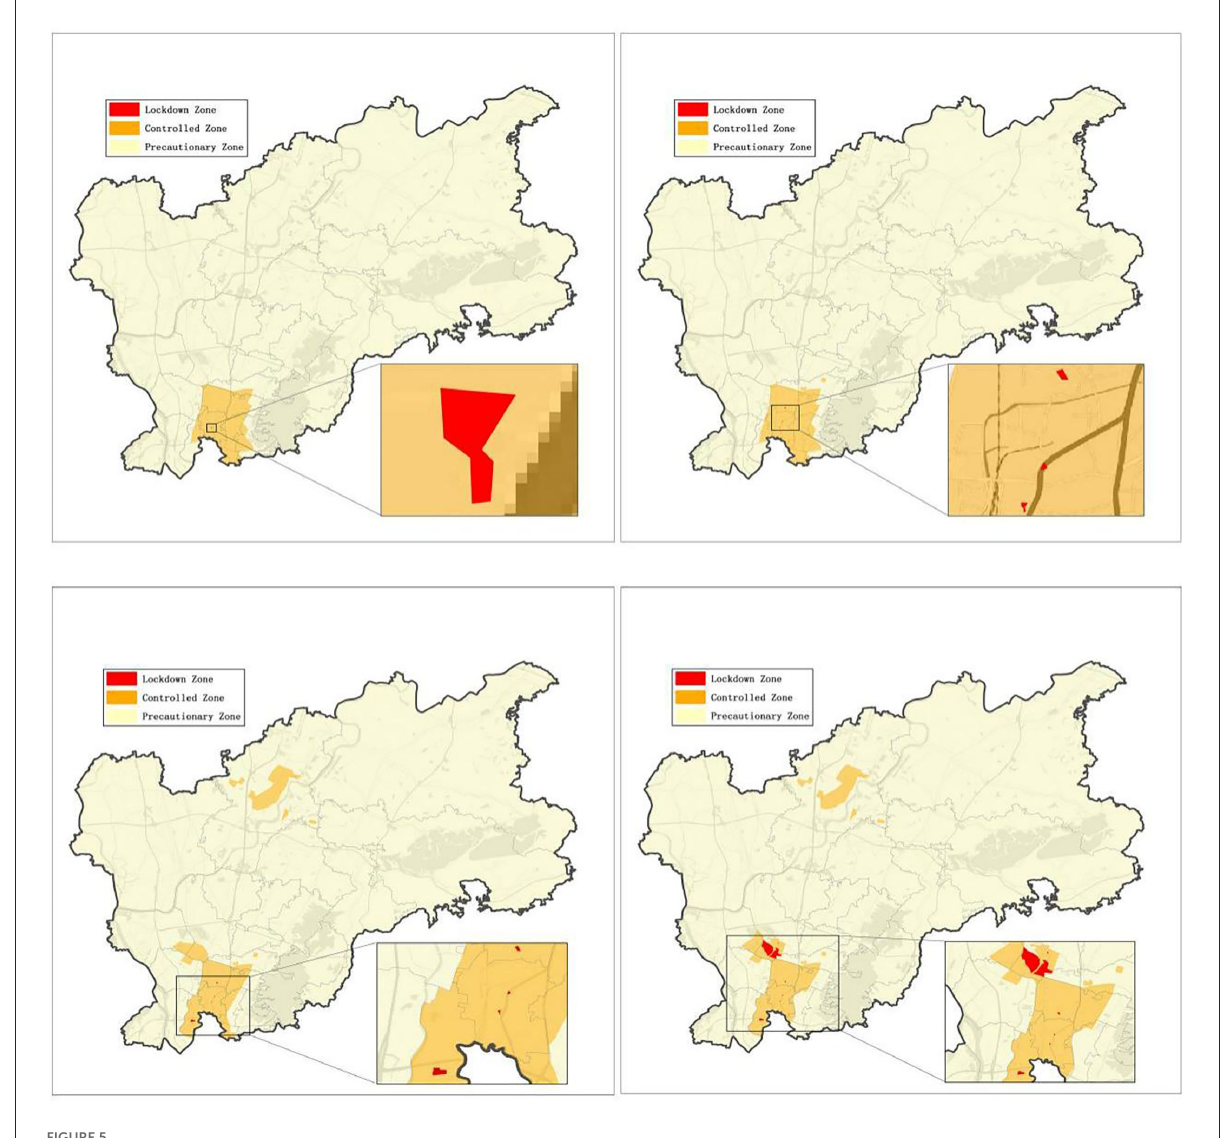
FIGURE5 Dynamical delimitation of at-risk zones in Baiyun